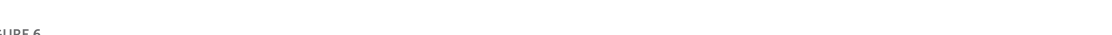
FIGURE6 ATS1 -transfected mice exhibited an apparent upward trend in the probability of finding the target quadrant (Kruskal-Wallis test). (F) Western blot of APP pathway proteins in WT and 5 × FAD mice infected with rAAV- ATS1-FLAG or Mock was shown. The relative band intensities showed reduced APP and sAPP β levels in ATS1 group when compared with respective mock control and sAPP α also exhibited a downward trend ( n = 6, APP in WT, P < 0.05, ATS1 vs. Mock; APP in 5 × FAD, P < 0.05, ATS1 vs. Mock; sAPP α in 5 × FAD, P < 0.01, ATS1 vs. Mock; sAPP β in 5 × FAD, P < 0.05, ATS1 vs. Mock, one-way ANOVA or Student’s t -test). (G) Western blot of CTFs in WT and 5 × FAD mice infected with rAAV- ATS1-FLAG or Mock was shown. The relative band intensities revealed the accumulation of CTF ATS 1 and reduced CTFs levels in ATS1 group when compared with respective mock control ( n = 6, CTF- β in 5 × FAD, P < 0.001, ATS1 vs. Mock; CTF- α in WT, P < 0.01, ATS1 vs. Mock, Student’s t -test). (H) Immunofluorescence showing A β plaques in the hippocampus. Scale bar, 100 µ m. Quantification of the surface area of A β plaques demonstrated the mitigated pathology by ATS1 overexpression ( n = 7 for 5 × FAD-Mock and n = 6 for 5 × FAD-ATS1, P < 0.05, ATS1 vs. Mock, Student’s t -test). (I) ELISA quantification of A β 40 and A β 42 in hippocampus lysates from 6-month-old mice certified the reduction of total A β s caused by ATS1 ( n = 6, A β 40 , P < 0.05, ATS1 vs. Mock; A β 42 , P < 0.01, ATS1 vs. Mock, Student’s t -test). * P < 0.05, ** P < 0.01, *** P < 0.001, **** P < 0.0001. Data were expressed as Mean ± SEM. ATS1, ADAMTS1; WT, wild type; Long exp., long exposure time; Short exp., short exposure